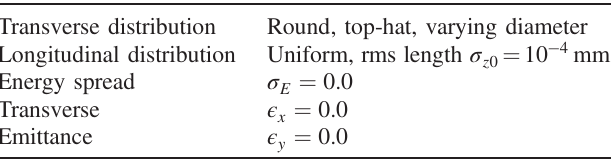
TABLE II. Important initial parameters of the bunch for the tracking